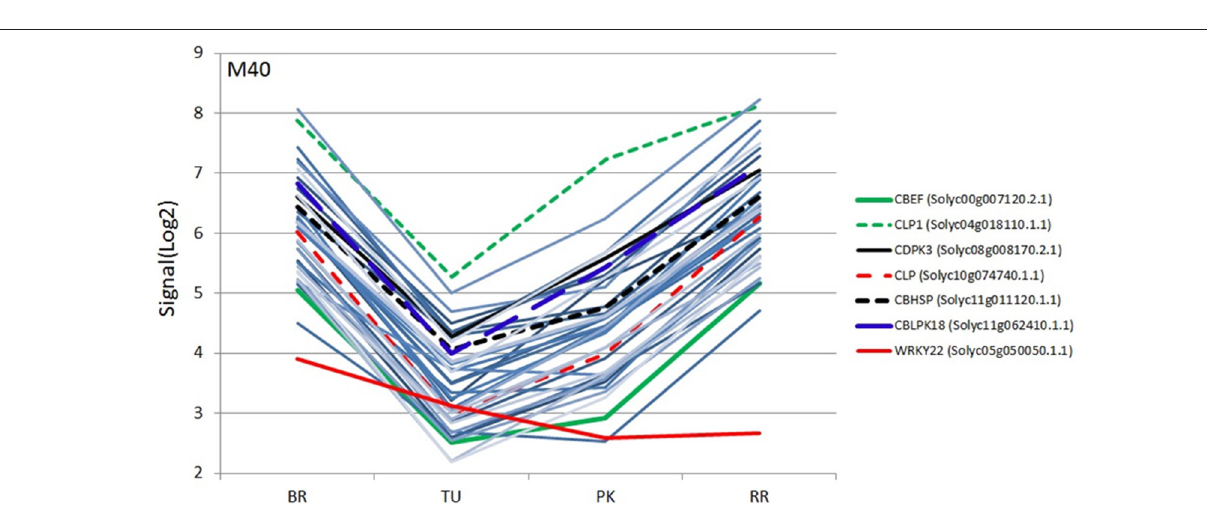
FIGURE 4 | Expression profiles (SignalLog2) of module M40 transcripts and WRKY22 TF in BR (Breaker), TU (Turning), PK (Pink) and RR (Red Ripe) stages based on the microarray data. The expression profiles of the WRKY22 and the six calcium signaling transcripts are represented by different colors (see inset) and the other transcripts with the same color lines (light